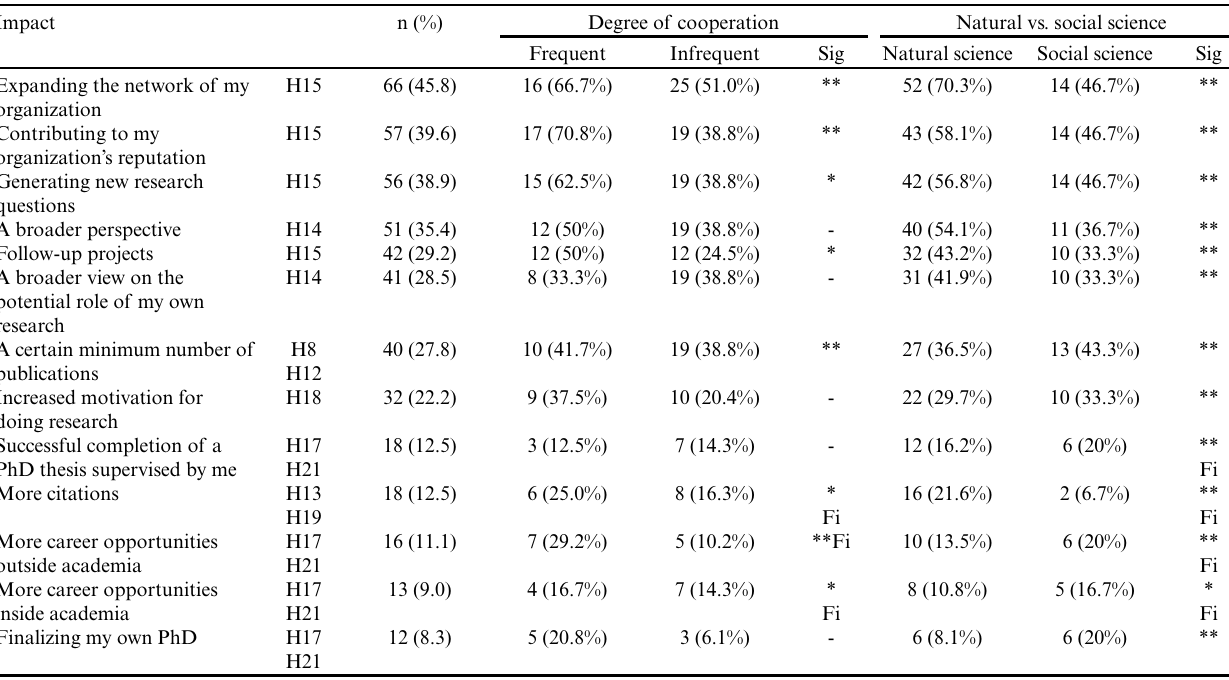
Table 8 . Reported impacts of the joint knowledge production (JKP)